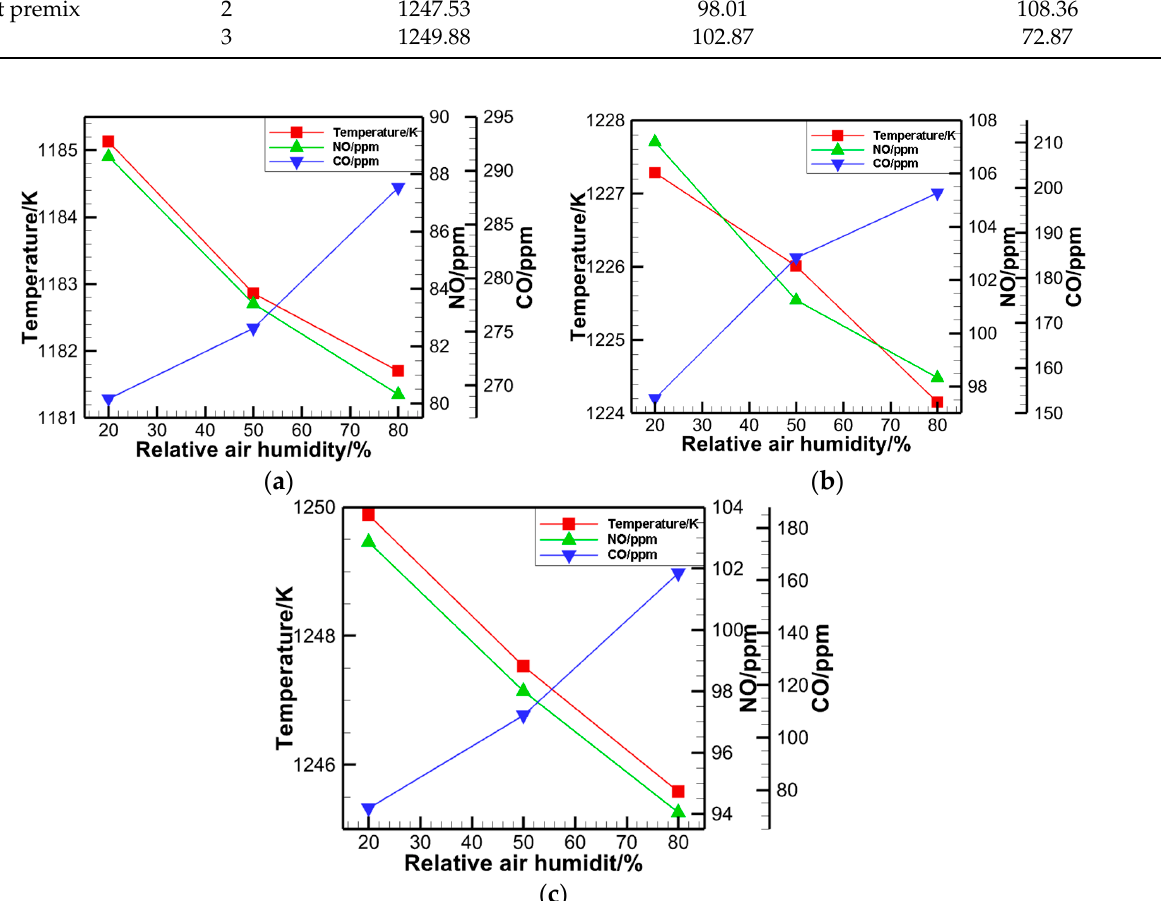
Figure 12. Influence of air humidity on startup emission. ( a ) Diffusion; ( b ) Sub-pilot premix; ( c ) Pilot premix. Table 10. Simulation results of humidity variation.